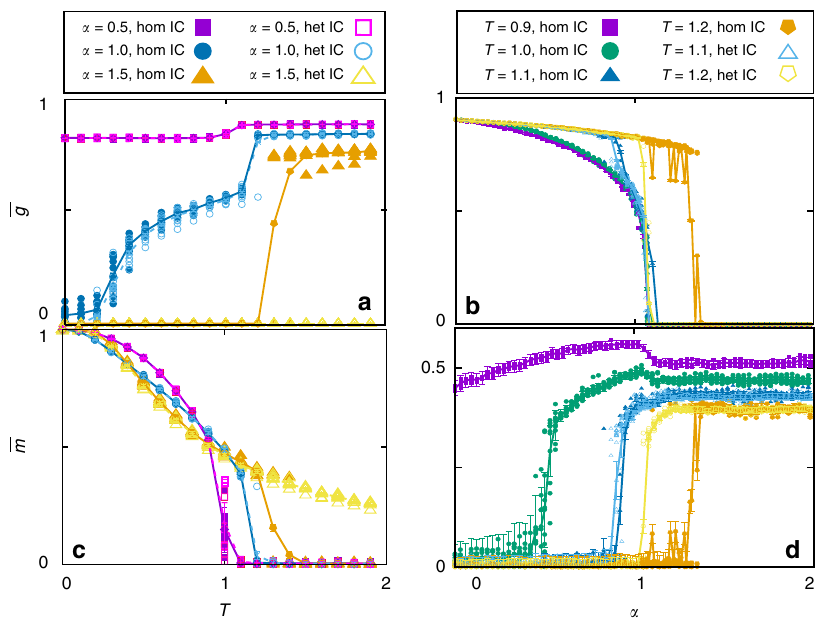
Fig. 3 Transition lines. Behaviour along the dotted lines marked in Fig. 4, for N = 1600, κ ∞ = 10 and n = 5. a and c show g T ð Þ and m T ð Þ , respectively, for different values of α , as indicated. b and d correspond, respectively, to g α ð Þ and m α ð Þ , for different temperatures as indicated. Solid points are for homogeneous IC and empty ones for heterogeneous IC, in every panel. Notice that some isolines go through the three phases: for T = 1.0 and 1.1 ( b and d ) the system is initially in the homogeneous memory phase, and an increase in α leads through α m T Þ to networks that are heterogeneous enough to c ð maintain memory, which further increases heterogeneity due to the feedback loop ( g α ð Þ decreases). A fi nal increase in α leads through α t T Þ to c ð heterogeneous networks. Similarly in a and c , the system visits for α = 1 the three phases: at very low T , α is high enough to develop heterogeneous memory networks, but a slight noise increase is enough to suppress heterogeneity, until noise is too high and memory is also lost, leading to the homogeneous noisy phase. Data points are averaged over 30 realizations and error bars correspond to (Fig. 3a, c for α = 0.5 and low T , and in Fig. 3b, d for T < 1.2 and different phases can be identi fi ed by monitoring the stationary low α ). The system is then able to reach and maintain memory, values of the order parameters, g ð α ; T Þ ; m ð α ; T Þ , and the Pearson correlation coef fi cient, r ð α ; T Þ , as illustrated in Fig. 3 (data for while the topological processes lead to a homogeneous network r ð α ; T Þ is not shown here since it provides similar information as con fi guration. Due to the existence of memory, there is a strong g ð α ; T Þ ). Analysis of these and similar curves for different correlation between the physiological state of the network, as parameter values leads to the phase diagram in Fig. 4. That is, measured by the currents I i , and its topology, as re fl ected by the there is a homogeneous memory phase for low α and T which is degrees k i (Fig. 1c). characterized by high m , high g and low (negative, almost zero) r